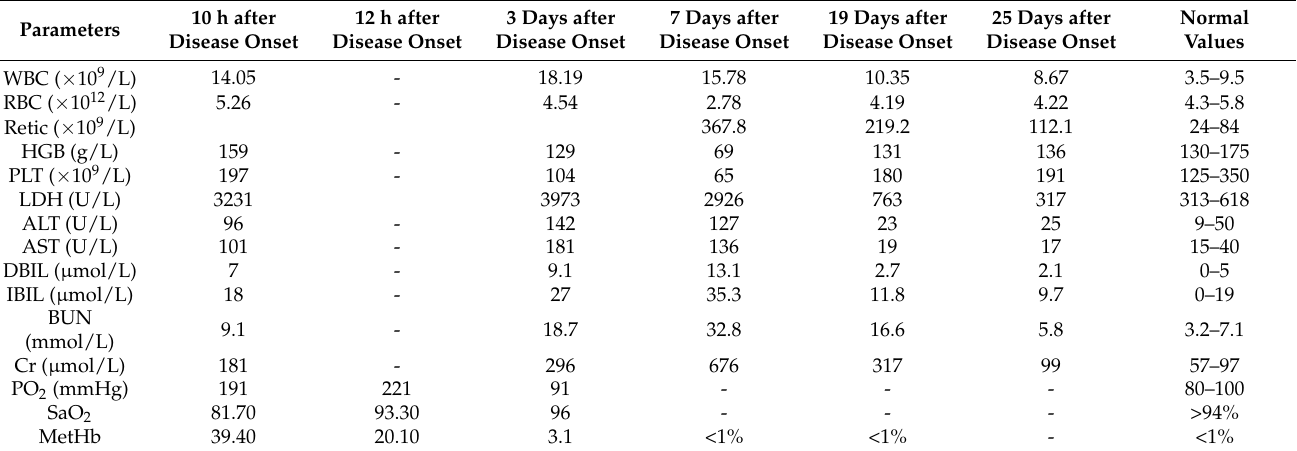
Table 1. Laboratory test